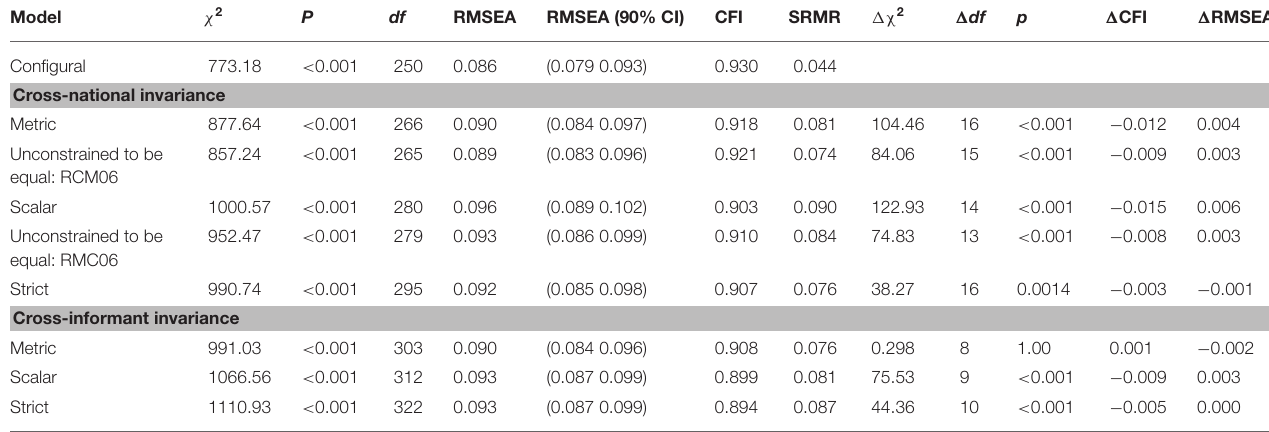
TABLE 4 | Cross-national and cross-informant invariance of the similarity model for the received support within the mother–child relationship. Model χ